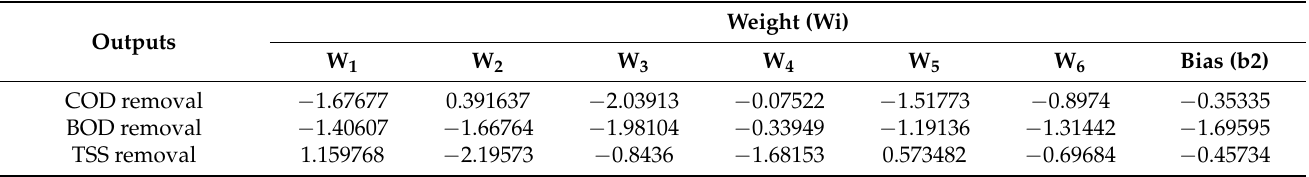
Table A5. Output weights and biases of the ANN model for aerobic